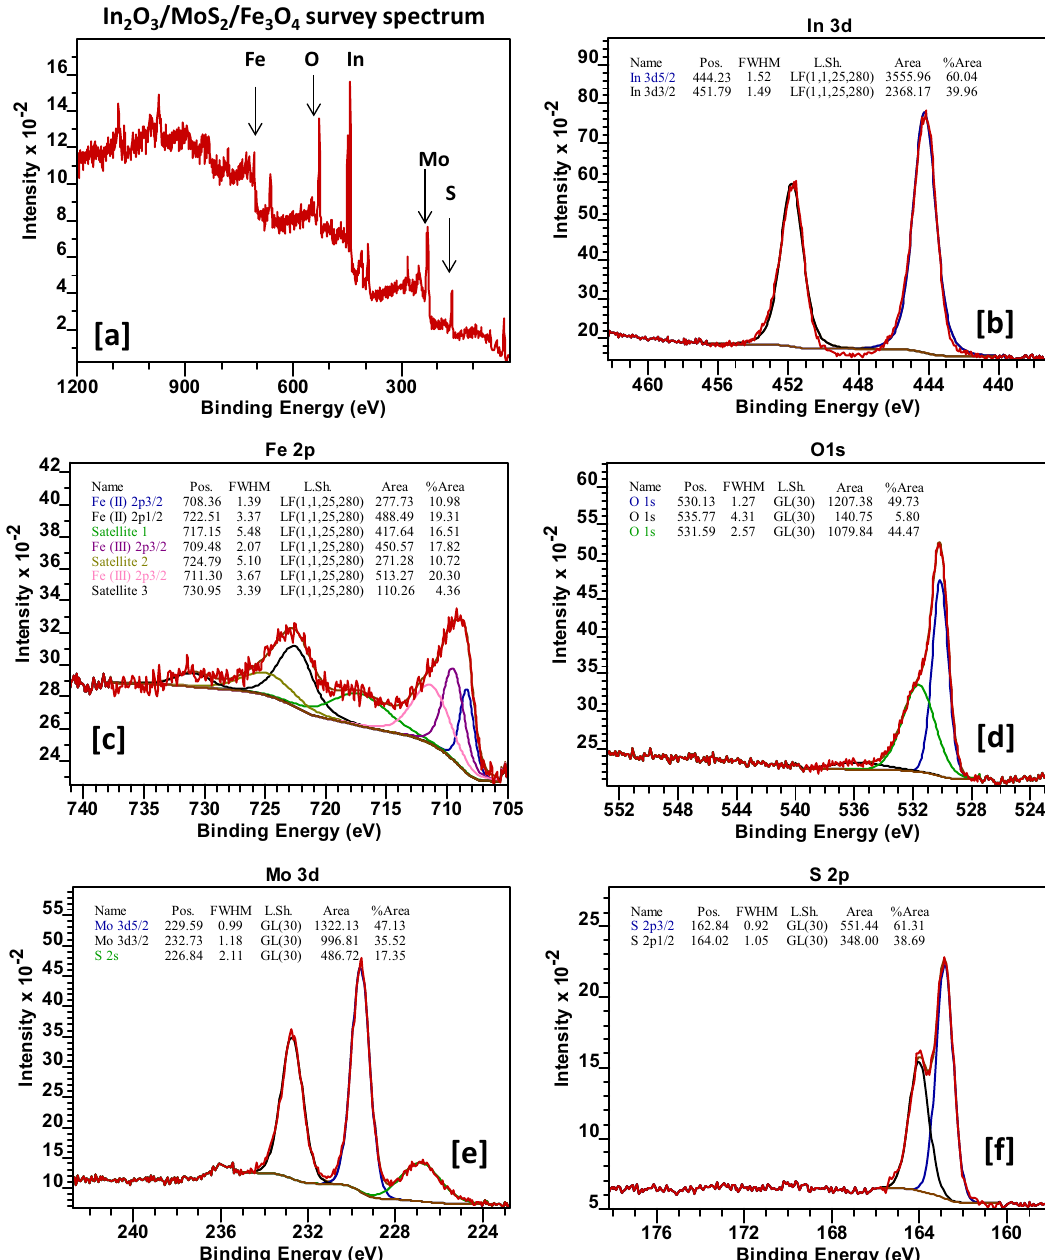
Figure 3. ( a ) XPS survey spectrum of In 2 O 3 /MoS 2 /Fe 3 O 4 , HR-XPS spectra of ( b ) In, ( c ) Fe, ( d ) O, ( e ) Mo and ( f ) S in In 2 O 3 /MoS 2 /Fe 3 O 4